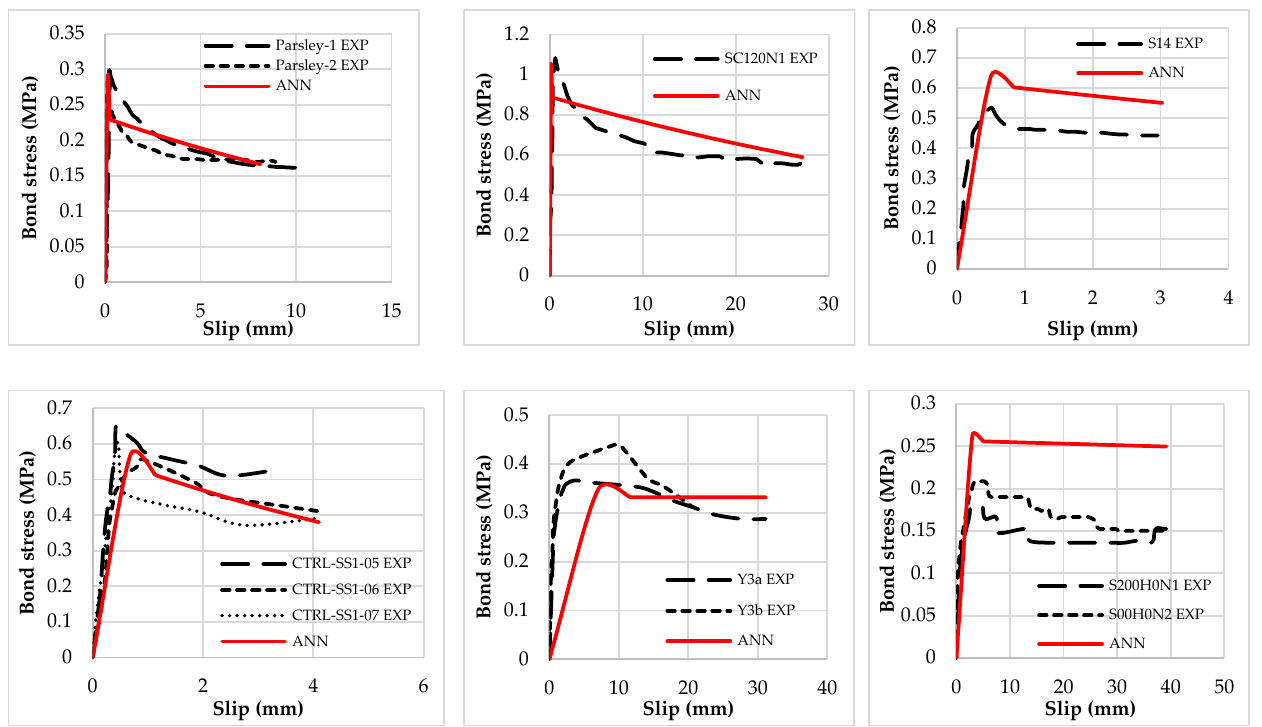
Figure 10. Experimental versus predicted interfacial behavior using ANN of squared specimens.